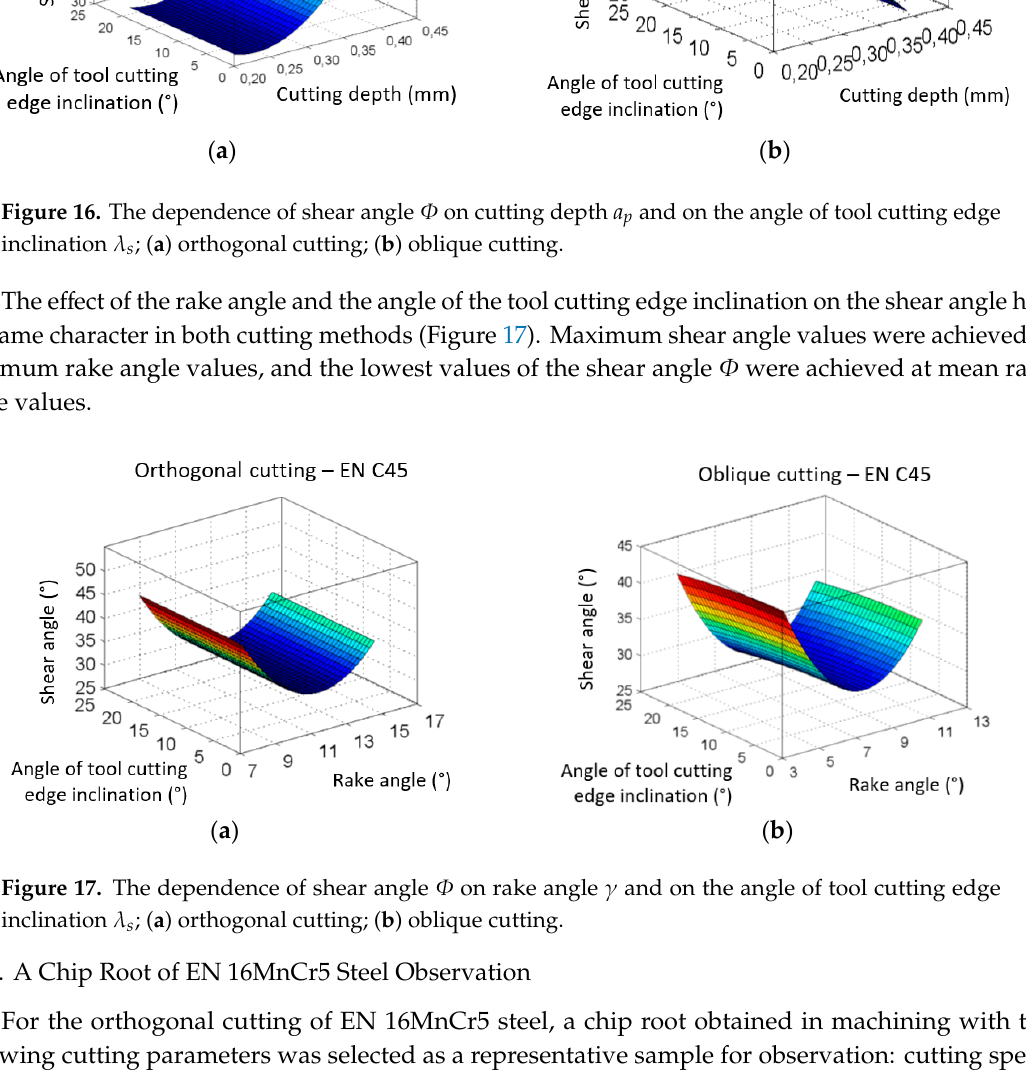
( b ) Figure 14. The dependence of shear angle Φ on cutting speed v c and on the angle of tool cutting edge inclination λ s ; ( a ) orthogonal cutting; ( b ) oblique cutting. The depth of the cut layer had a significant influence on the shear angle for both types of machining. For orthogonal cutting (Figure 15a), the rake angle affected the change in shear angle slightly more than for oblique cutting (Figure 15b). For orthogonal cutting, the maximum values of the shear angle were achieved at the maximum values of the cutting depth, and for oblique cutting, maximum values of shear angle were observed at the maximum rake angle. ( a ) ( b ) Figure 15. The dependence of shear angle Φ on cutting depth a p and on rake angle γ ; ( a ) orthogonal cutting; ( b ) oblique cutting.